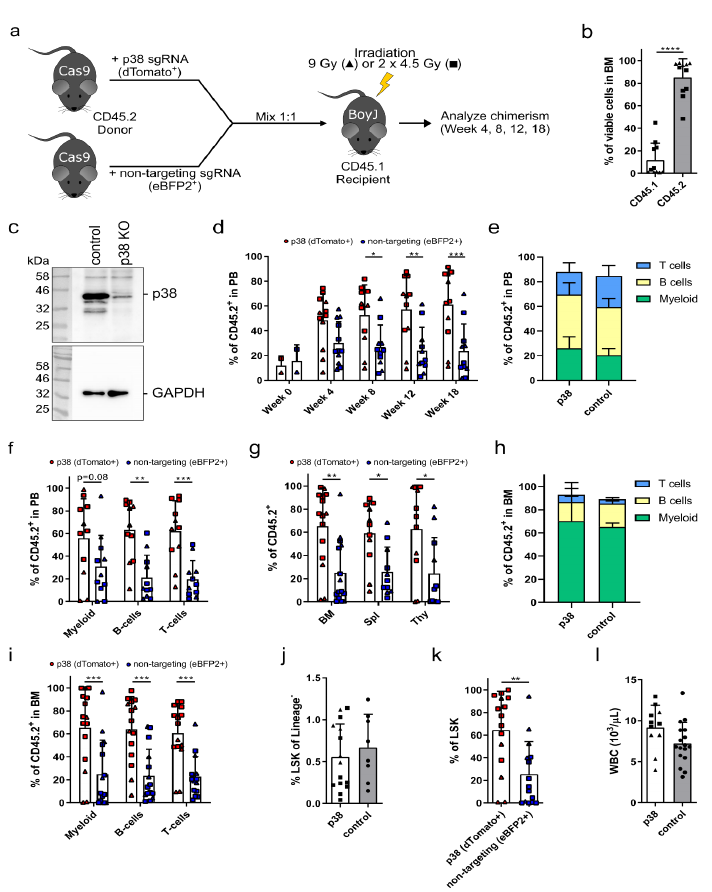
Figure 2. CRISPR-Cas9-mediated knockout of p38 increases the repopulating capacity of hematopoietic stem and progenitor cells (HSPCs). ( a ) Schemata of the competitive bone marrow transplantation. Usinglentiviral vectors, p38 was knocked out in CD45.2 + HSPCs from Cas9 mice (labeled with a dTomato fluorescent reporter) and transplanted into irradiated CD45.1 mice. As competitors, HSPCs were transduced with a nontargeting sgRNA and an eBFP2 fluorescent reporter. Mice were irradiated with either a single dose of 9 Gy (triangles) or a fractionated dose of 2 × 4.5 Gy (squares). Peripheral blood was analyzed 4, 8, and 12 weeks after transplantation. On week 18, the animals were euthanized for final analysis. ( b ) The donor cell chimerism was analyzed as CD45.1 + and CD45.2 + cells in the bone marrow 18 weeks after transplantation. ( c ) The knockout of p38 was verified by Western blot analysis of a representative bone marrow sample. GAPDH was used as loading control. KO = knockout. ( d ) The frequency of p38 knockout HSPCs (red) and competitor cells (blue) was monitored over time in the peripheral blood of transplanted animals. ( e ) The lineage distribution for myeloid (CD11b + ), B (B220 + ), and T (CD3 + ) cells was assessed in the peripheral blood of transplanted animals 18 weeks after transplantation in comparison to age-matched control animals. ( f ) The frequency of dTomato + p38 knockout cells (red) and eBFP2 + competitor cells (blue) was measured in myeloid, B, and T cells in the peripheral blood on week 18 after transplantation. ( g ) Bone marrow (BM), spleen (Spl), and thymus (Thy) were analyzed for the presence of p38 knockout cells (red) and competitor cells (blue) 18 weeks after transplantation. ( h ) The lineage distribution in the bone marrow was analyzed 18 weeks after transplantation by measuring CD11b + myeloid cells, B220 + B cells, and CD3 + T cells. ( i ) The presence of dTomato + p38 knockout cells and eBFP2 + competitor cells were assessed in myeloid, B, and T cells in the bone marrow of transplanted animals on week 18 post-transplantation. ( j ) The frequency of Sca1 + c-Kit + Lineage - (LSK) cells was measured in the bone marrow 18 weeks after transplantation. Circles refer to untransplanted age-matched control animals. ( k ) On week 18 post-transplantation, the frequency of dTomato + p38 knockout cells (red) and eBFP2 + competitor cells (blue) were analyzed in LSK cells in the bone marrow of transplanted mice. ( l ) The white blood cell count (WBC) was quantified in the peripheral blood in mice transplanted with p38 knockout cells on week 18 after transplantation and compared to age-matched, untransplanted control animals (circles). Statistics: n = 11, mean ± SD, two independent experiments, t -test ( b , j – l ), two-way ANOVA comparing row means ( d , f , g , i ) or column means only ( e , h ), * p < 0.05, ** p < 0.01, *** p < 0.001, **** p <